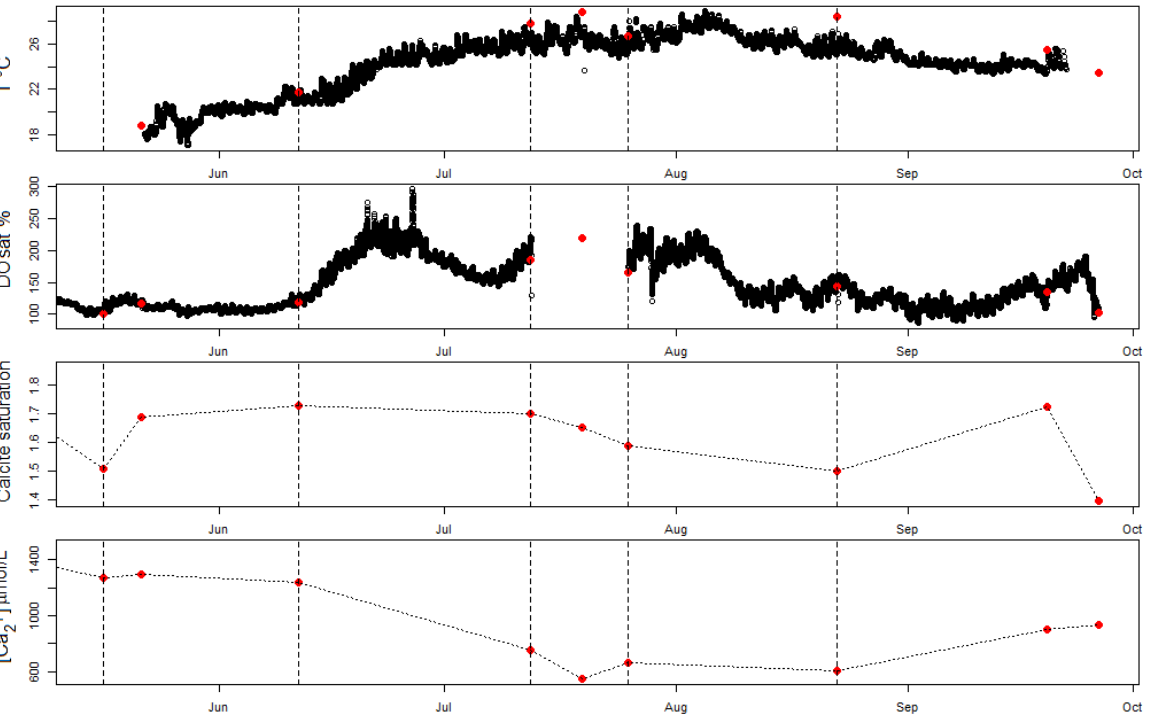
Figure 5. Seasonal evolution of surface water variables in Sau Reservoir. The high-frequency measurements of temperature (T) (in degrees Celsius) and dissolved oxygen saturation (DOsat) (dark points) are shown together with the spot surface water measurements (red points) of T, DOsat, calcite SI and [Ca2+] at the time of the campaigns.